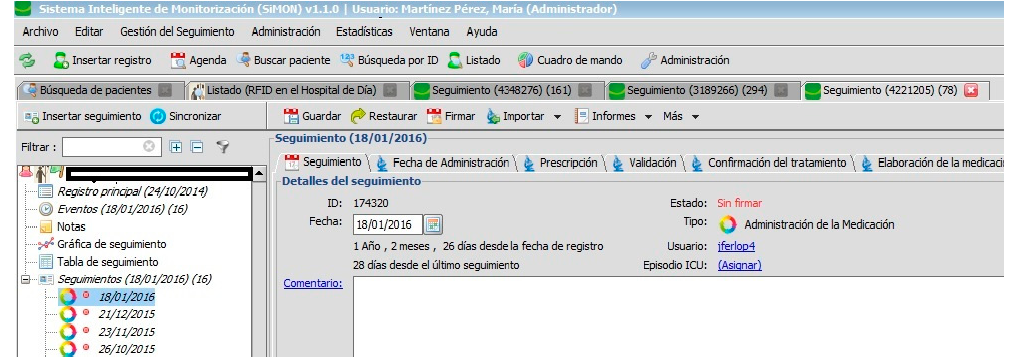
Figure 3. Patient monitoring.